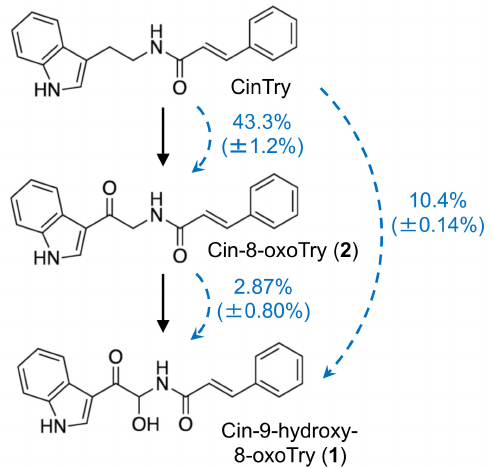
Figure 7. Incorporation of deuterium-labeled cinnamic acid amides into 1 and 2 . Blue arrows indicate the incorporation of labeled compounds. Percentage values indicate the mean ( ± SD) rates of labeled to unlabeled compound ( n = 3). CinTry, cinnamoyltryptamine.